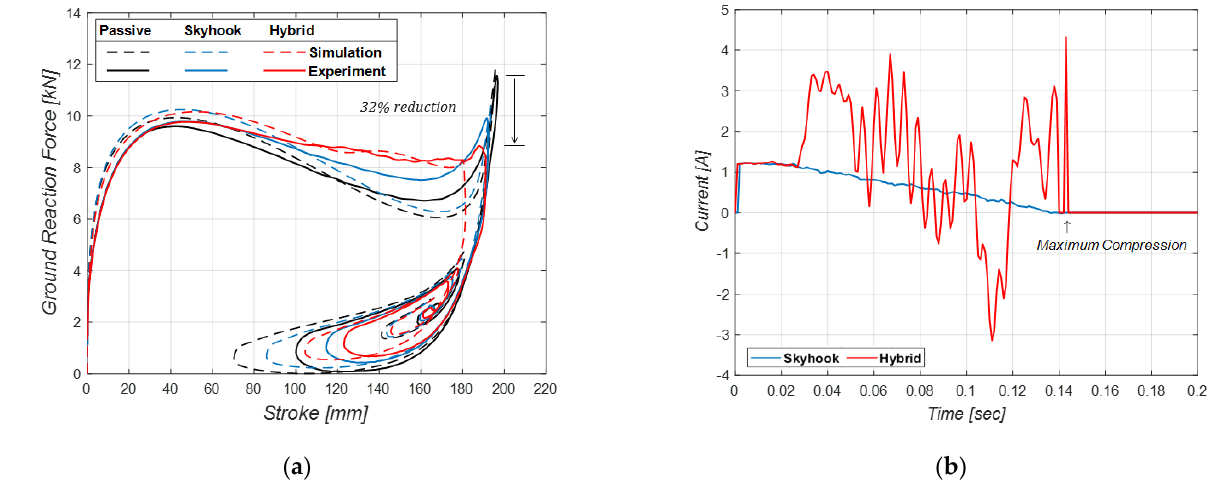
Figure 11. Drop test results for control algorithm (sink speed = 3.1 m/s, sprung mass = 245 kg): ( a ) Ground reaction force for stroke diagram; ( b ) Control input, current. Table 2. Drop test